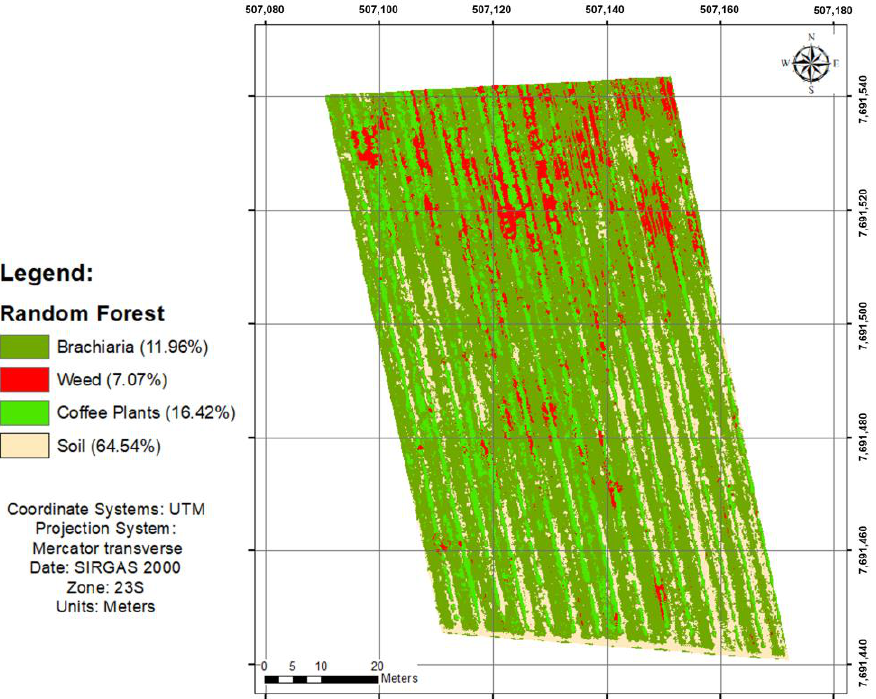
Figure 8. Land cover map with the RF classifier and the corresponding percentages for each class.